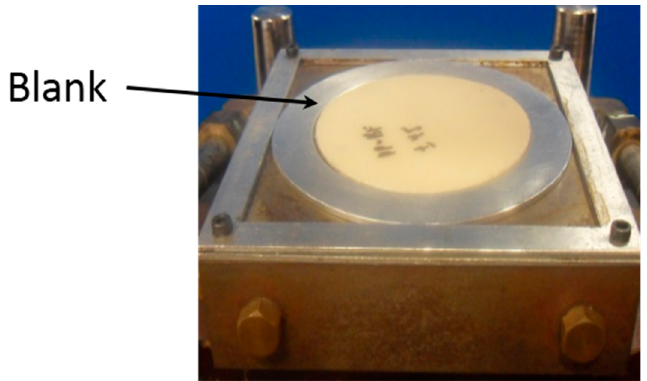
Figure 4. Blank from bamboo fabric-PLA composite laminate.